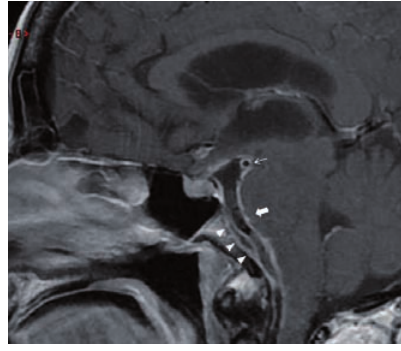
Figure 1. T1 Axial MRI showing severe dilatation of the lateral and third ventricles and a lesion in the region of the right cau- date